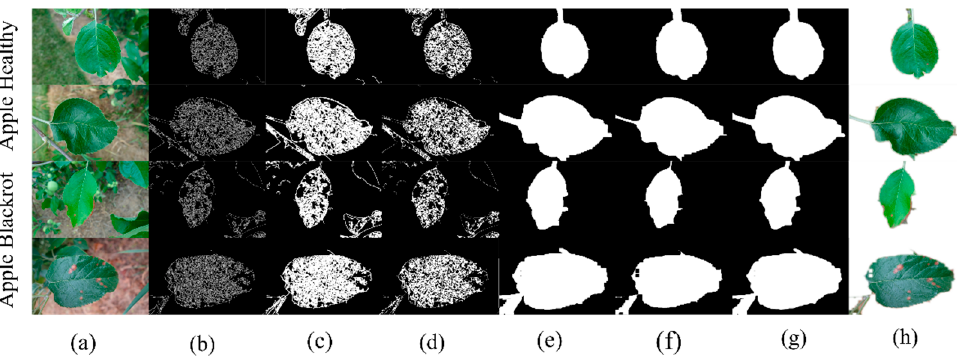
Figure 7. Results of background removal algorithm. ( a ) Input images; ( b ) canny edge detection; ( c ) edge dilation; ( d ) edge erosion; ( e ) mask dilation; ( f ) mask erosion; ( g ) Gaussian blur; ( h ) back- ground removed image.